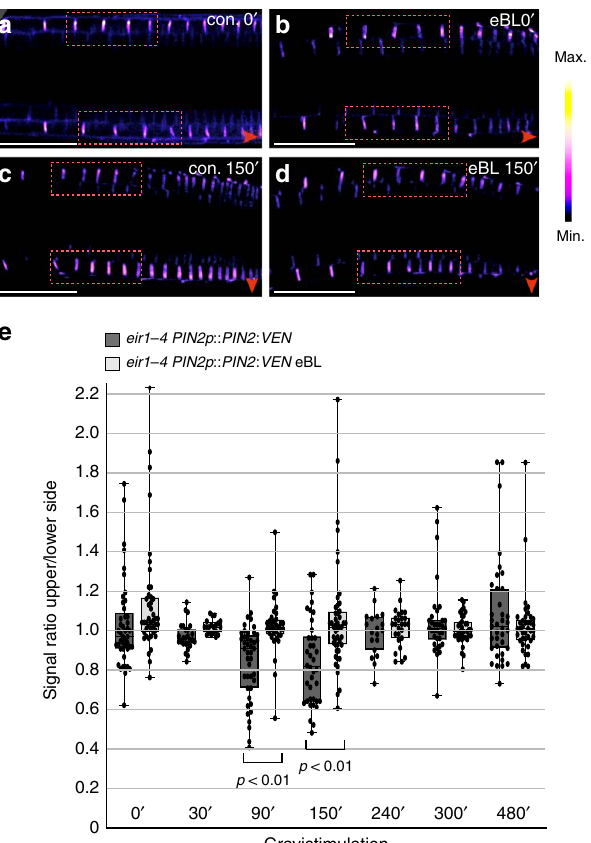
Fig. 6 PIN2 expression in gravistimulated roots is controlled by brassinolide. a – d Stacks of z-sections generated for analysis of PIN2:VEN signal distribution (see ‘ e ’ ), at time point zero ( a , b ) and after 150 min of gravistimulation ( c , d ). Relative signal intensities were determined measuring signals in adjacent root epidermis cells in the bending zone (highlighted by dotted red rectangles). Red arrowheads: direction of gravity vector. e PIN2:VEN signal ratios in epidermis cells at upper vs. lower side of gravistimulated root meristems. 19 – 47 roots were analyzed for each dataset. One-way ANOVA with post-hoc Tukey HSD test revealed signi fi cant differences between control roots on PNS and roots pre-treated with 100 nM eBL, after 90 and 150 min of gravistimulation. Whiskers in box plots cover the entire range of outliers obtained in the datasets; gray boxes display fi rst and third quartiles; center line: median; dots: values obtained. Scale bars: a, b = 50 μ m. Source data are provided as Source Data fi le.